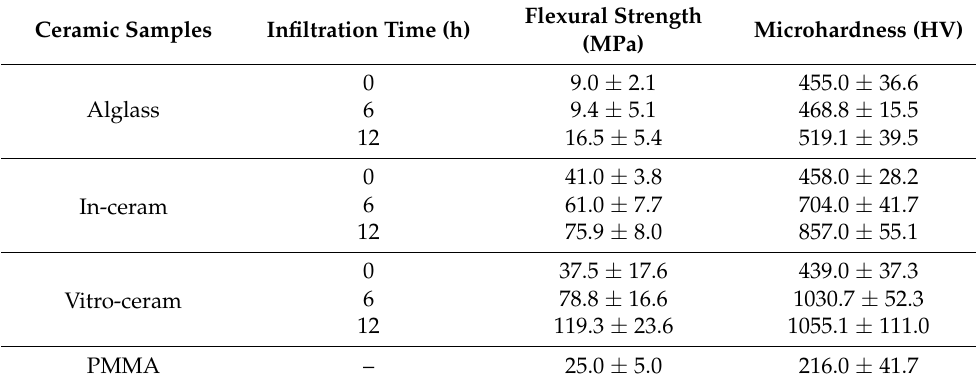
Table 5. Flexural strength and microhardness of alumina samples sintered at 1400 ◦ C and infiltrated with